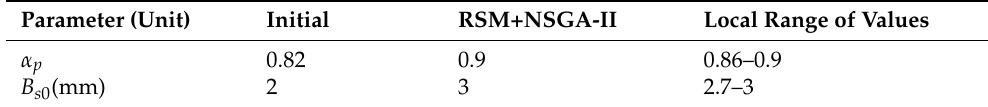
Table 4. The range of values for local optimization of structural